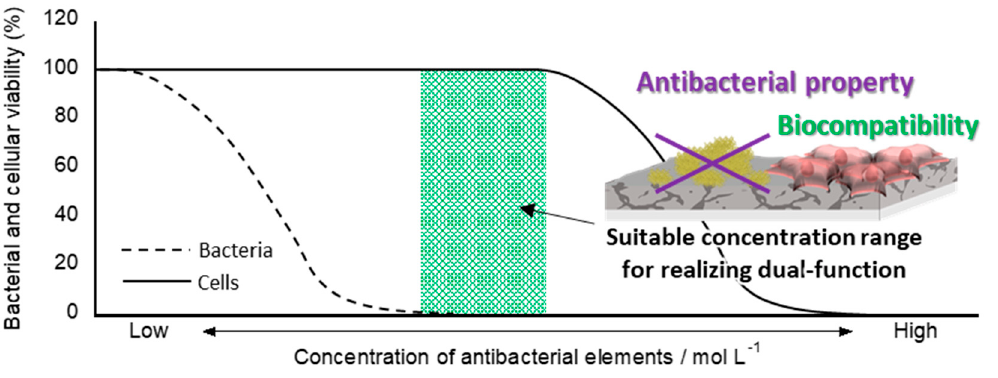
Figure 3. Conceptual diagram of the suitable concentration range (green-colored area) of antibacterial elements for the dual-functionalization of the Ti surface.